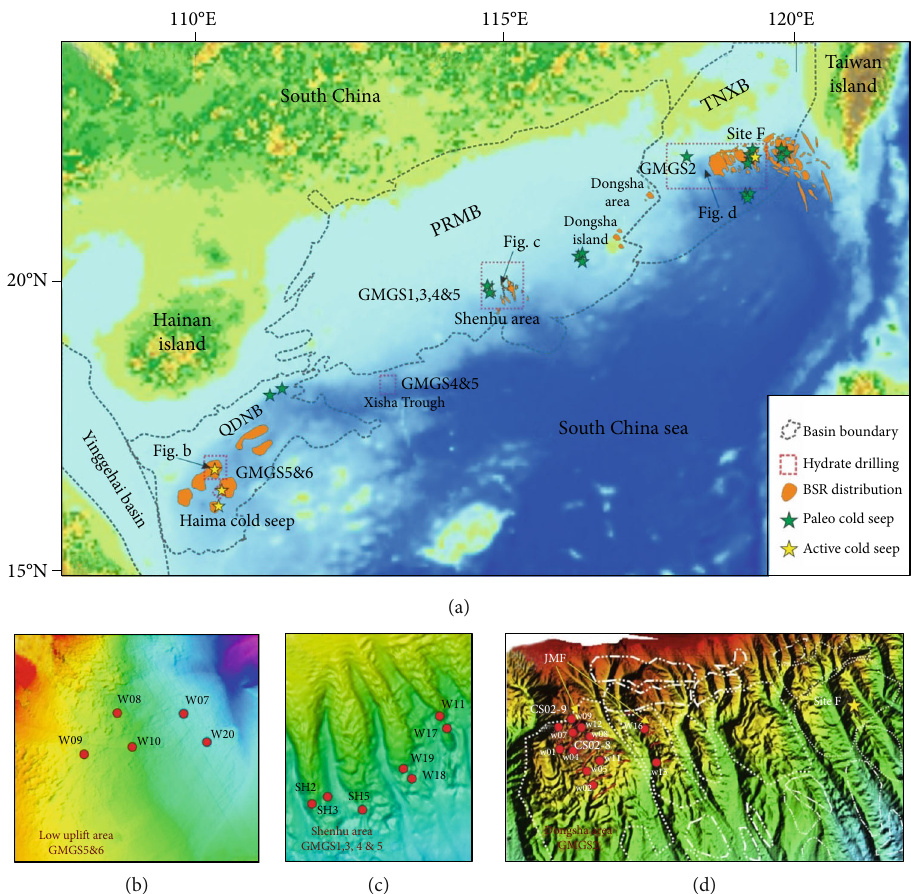
Figure 1: (a) Distribution of cold seep systems associated with gas hydrate accumulations in the marginal basins in the northern South China Sea. The distribution of the BSR is from Wang et al. [120], and the distribution of the cold seep system is modi fi ed after Feng et al. [6]. (b) Gas hydrate drilling zone and partial sampling sites in the low uplift area of the Qiongdongnan Basin (QDNB) for expeditions GMGS 5 and 6 [120]. (c) Gas hydrate drilling zone and partial gas hydrate drilling/coring sites in the submarine ridges in the Shenhu area in the Pearl River Mouth Basin (PRMB) for expeditions GMGS 1, 3, and 4. (d) Distribution of the gas hydrate drilling sites implemented in expedition GMGS2 and the locations of the Jiulong Methane Reef (JMF) and cold seep Site F (yellow star) in the Taixinan Basin (TXNB). The red circles indicate the location of the gas hydrate drilling/coring sites, and the white dotted lines indicate the distribution of the BSR, modi fi ed after Konno et al.